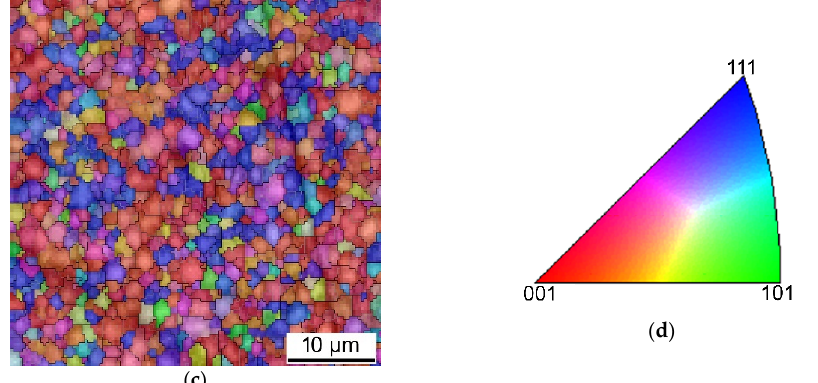
Figure 7. SEM OIM images for Al matrix of swaged laminate ( a ); HT1 laminate ( b ); HT2 laminate ( c ); OIM legend ( d ).